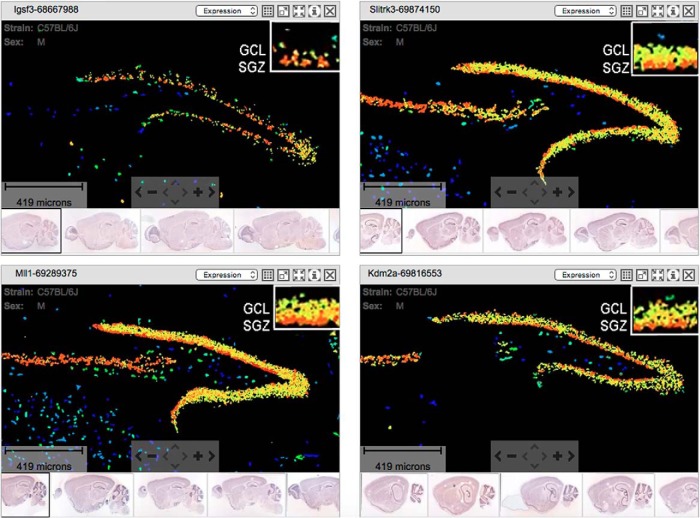
Consistent spatial expression patterns of retroviral enriched genes in mouse SGZ. Representative in situ hybridization images from the Allen Brain Atlas for Igsf3, Slitrk3, MII1, and Kdm2a show SGZ enrichment, which is consistent with our RNAseq data. The expression energy image display highlights the cells with the highest probability of gene expression using a heat map color scale (from low/blue to high/red).